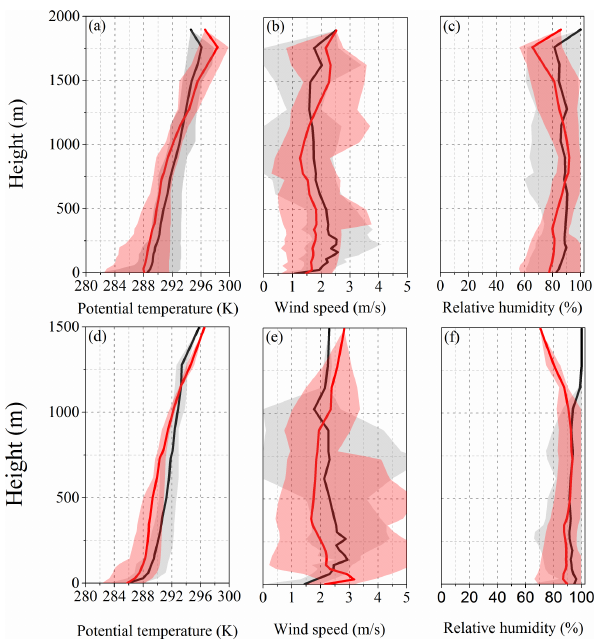
Figure 5. Comparisons of observed and simulated vertical profiles of potential temperature, wind speed, and relative humidity in the daytime (a, b, c) and nighttime (d, e, f) at Chengdu (site 1 in Fig. 1) during 2–7 January 2017. The red and gray shaded areas represent the variation range of simulation and observation in all vertical pro- files with averaged values (lines), respectively.